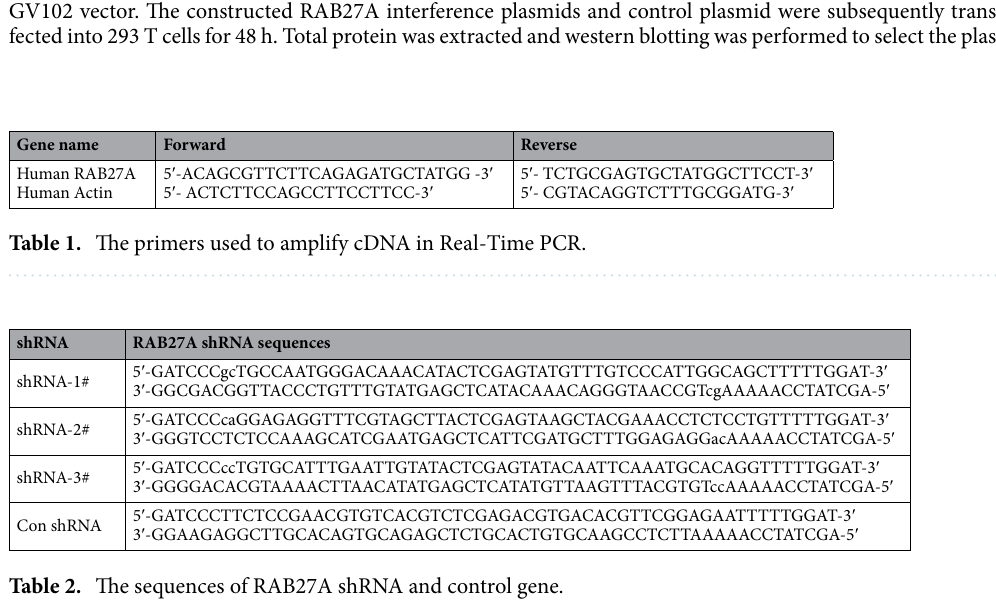
Table 2. The sequences of RAB27A shRNA and control